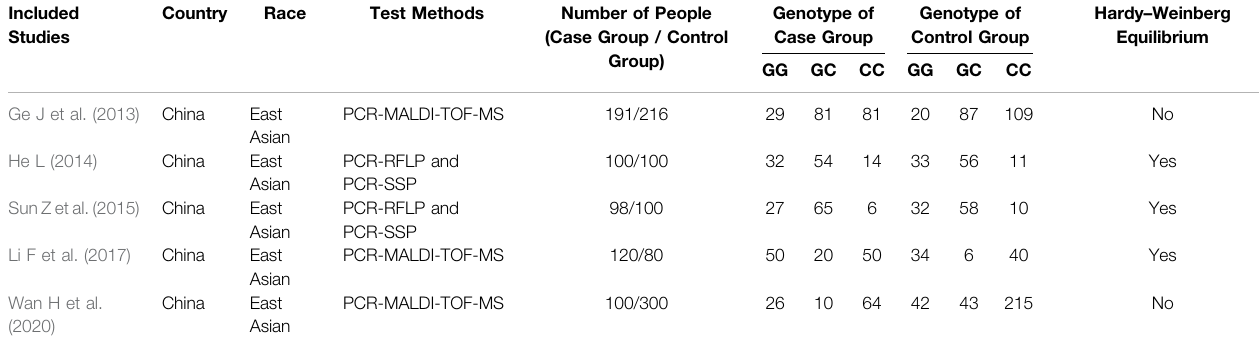
TABLE 3 | Basic features of the included articles about research of correlation between SNP1123 and ITP susceptibility. Included